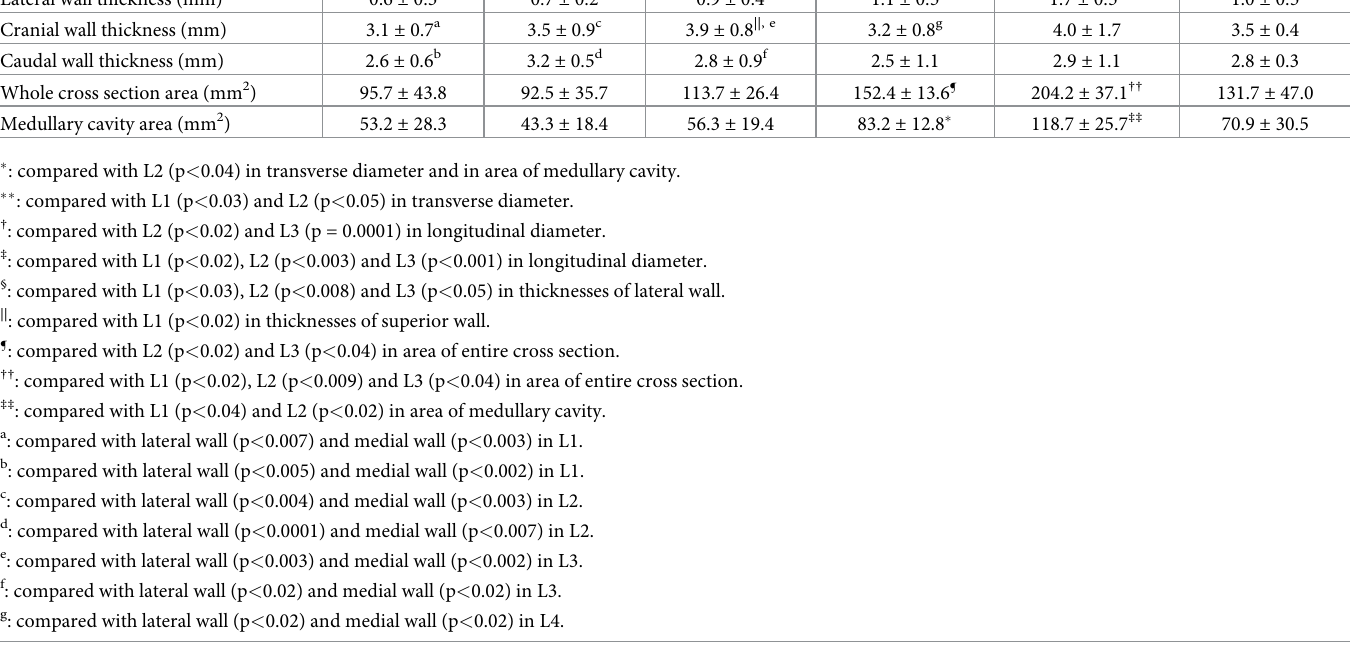
bone area fraction in the lateral region was lowest among the four regions at L1, L2 and L3 and significantly lower than that in the medial region at L4 and L5 (p < 0.0004 and p < 0.002, respec- tively). The bone area fraction in the medial region was highest among the four regions at all levels except for L4 (p < 0.004 for medial vs. lateral, p < 0.03 for medial vs. caudal, and p = 0.26 for medial vs. cranial at L4, respectively). The lateral and caudal regions at L1, L2 and L3 showed significant differences between them (p < 0.002, p < 0.02, and p < 0.0006, respectively), but there were no significant differences at L4 and L5. The area fraction at the caudal region was lower than that in the cranial region at L5 (p < 0.0006). While the value of the bone area fraction in the medial region was over 95% at all spinal levels, that in the lateral region was less than 64% at all spinal levels and that in the caudal region was less than 67% at L4 and L5 ( Fig 3 , Table 4 ).